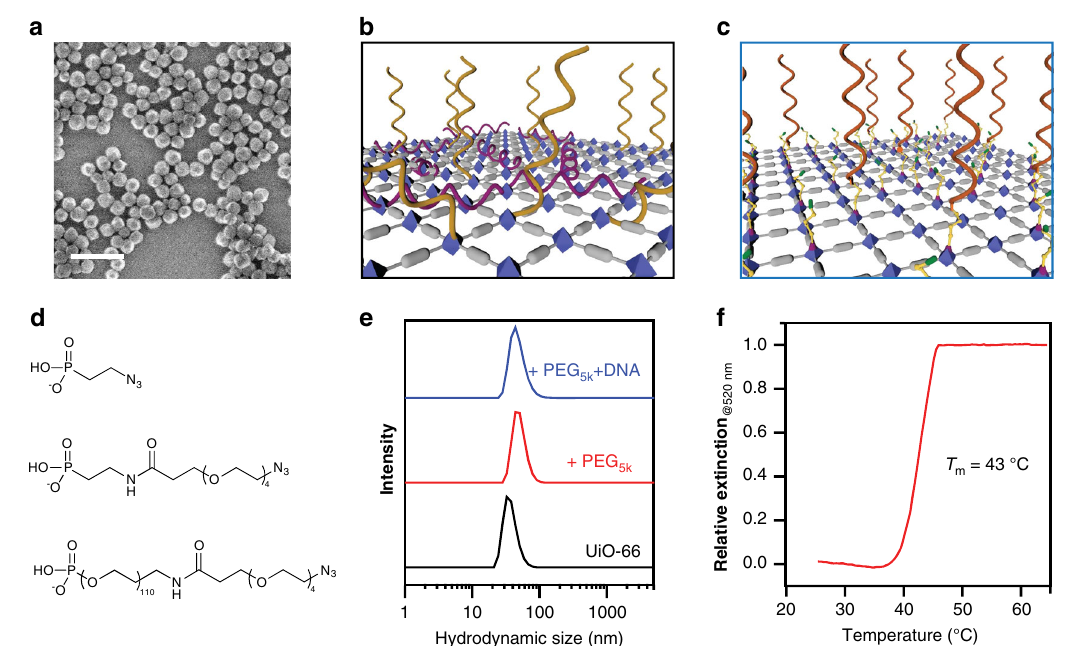
Fig. 2 Synthesis and characterization of UiO-66 MOF PAEs. a SEM image of UiO-66 MOF NPs. Scale bar is 100 nm. b Schematic illustration showing how direct DNA surface functionalization suffers from multi-valent DNA backbone binding to MOF surface SBUs. c The proposed strategy passivates the MOF surface with an azide-functionalized PEG polymer layer that (1) allows alkyne-modi fi ed DNA to be effectively coupled, (2) prevents DNA backbone binding, and (3) increases MOF NP colloidal stability. d Three phosphate/phosphonate-PEG-azide ligands with varying number of ethylene glycol units were studied. e DLS analysis of as-synthesized UiO-66 NPs in water (black), PEG 5k -modi fi ed UiO-66 NPs (red), and DNA functionalized UiO-66 PAEs in 0.5 M NaCl (blue). f Melting transition of MOF – Au PAE DNA-linked aggregates, monitored as a function of change in extinction at 520nm via UV-vis